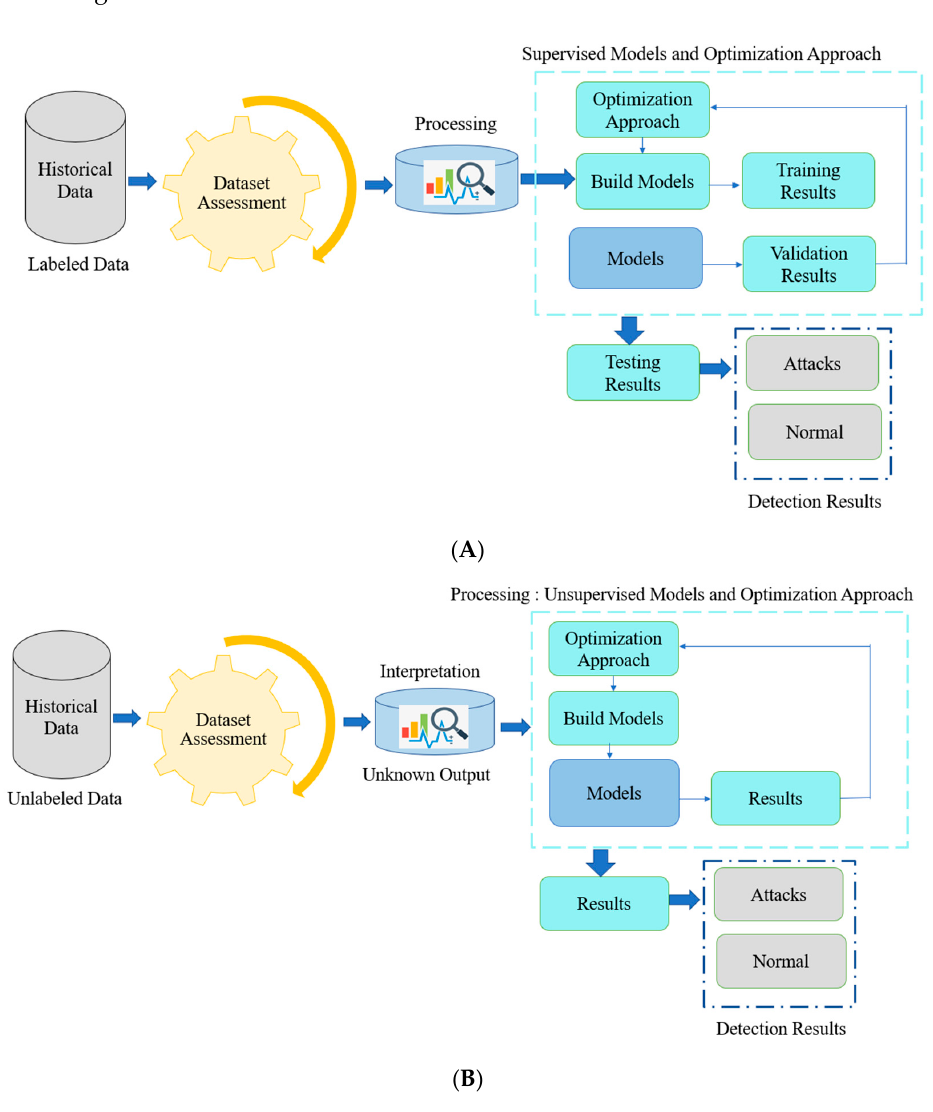
Figure 1. Supervised and Unsupervised Learning Working Flow. ( A ) Supervised Working Flow ( B ) Unsupervised Working Flow.